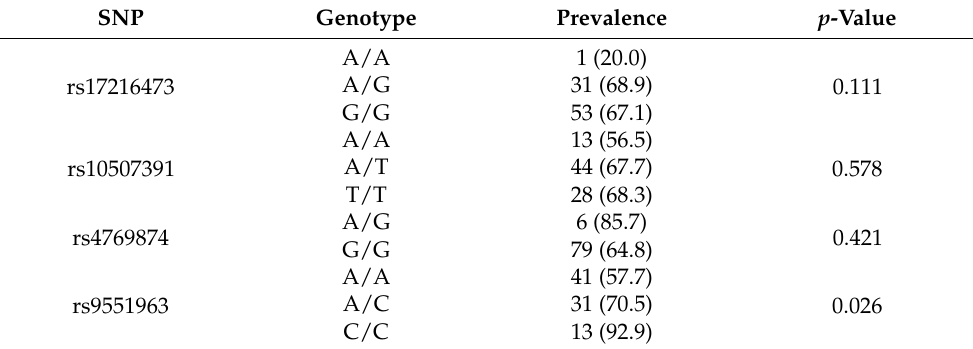
Table 4. Prevalence of PAD for each SNP.